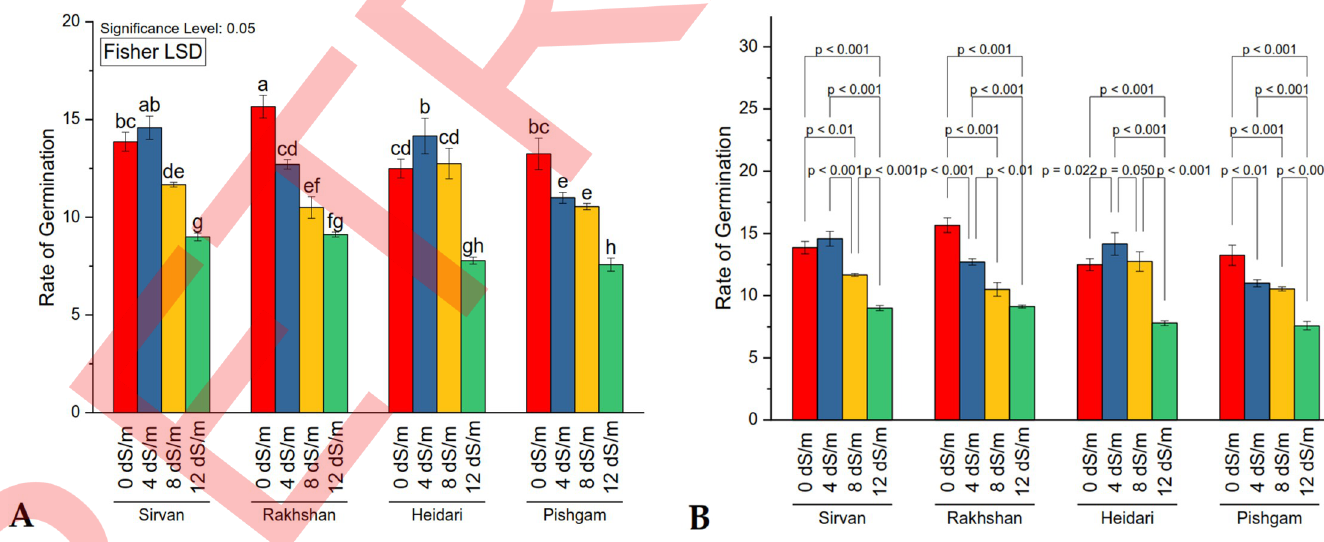
Fig 2. Effects of salinity on germination percentage in wheat varieties. A) Means are average of four replicates. Different values showed significant difference at p < 0.05 compared by LSD. B) Different values at bars are p values obtained during LSD comparison of wheat varieties and salinity levels.